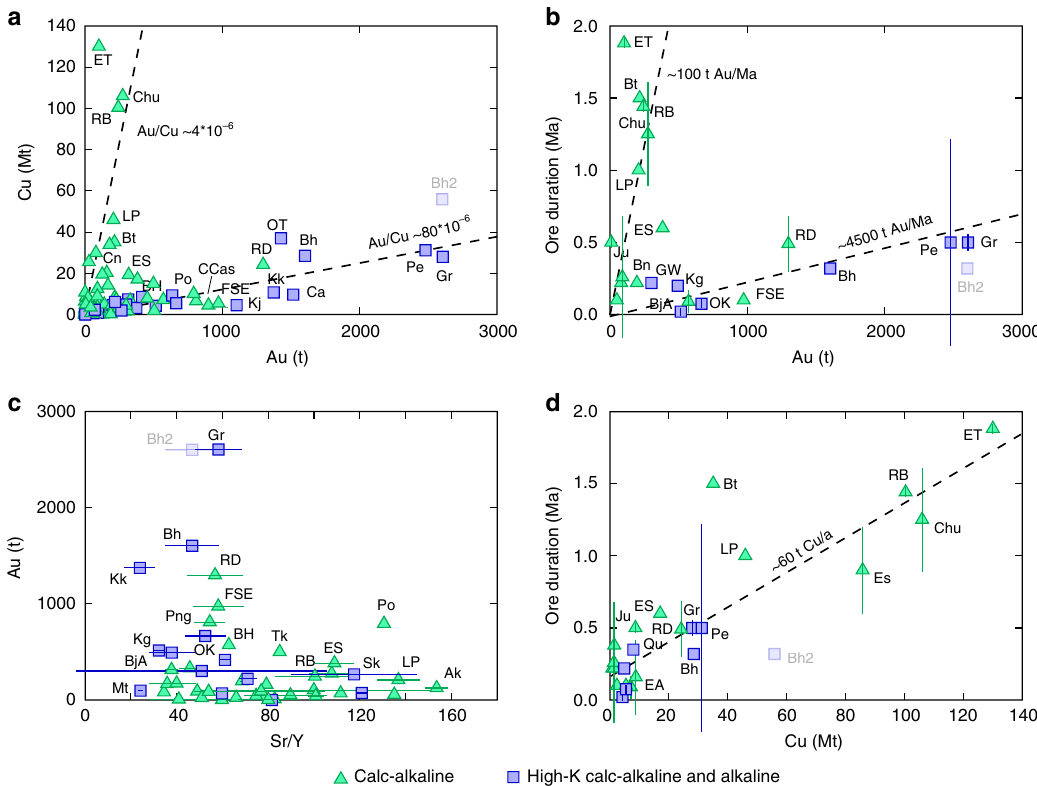
Fig. 1 Metal endowments, geochemistry of associated rocks and ore durations of Cu-rich vs. Au-rich porphyry deposits. a Cu (Mt) vs. Au (tons) of porphyry Cu – Au deposits; b ore duration (Ma) vs. Au (tons) of porphyry Cu – Au deposits. All deposits are roughly distributed along either one or the other of the two dashed lines allowing the identi fi cation of two distinct families of porphyry Cu – Au, the Cu-rich (Au/Cu~4 × 10 − 6 and ~100 t Au Ma − 1 ) and the Au-rich (Au/Cu~80 × 10 − 6 and ~4500 t Au Ma − 1 ). The dashed lines represent average rates of Cu and Au deposition and are not statistically best- fi tted lines; c Au (tons) vs. Sr/Y average values of magmatic rocks associated with porphyry Cu – Au deposits. The bars for Sr/Y values are 1 s.d. uncertainties calculated from the available Sr/Y values of magmatic rocks associated with each deposit (see Supplementary Data 1); d ore duration (Ma) vs. Cu (Mt) of porphyry Cu – Au deposits. The bars associated with the ore duration values are propagated 2 s.d. uncertainties as explained in Supplementary Note 1. Abbreviations of porphyry deposits: Ak Aksug, BH Batu Hijau, Bh Bingham, BjA Bajo de la Alumbrera, Bt Butte, Ca Cadia, CCas Cerro Casale,